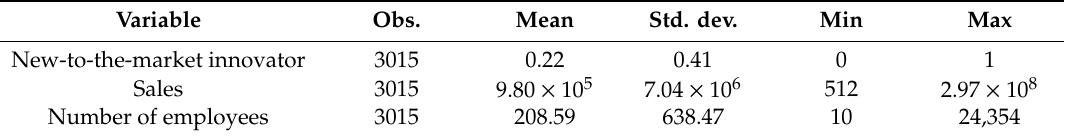
Table 1. The summary of statistics from the sample of manufacturing enterprises in 2014. Variable